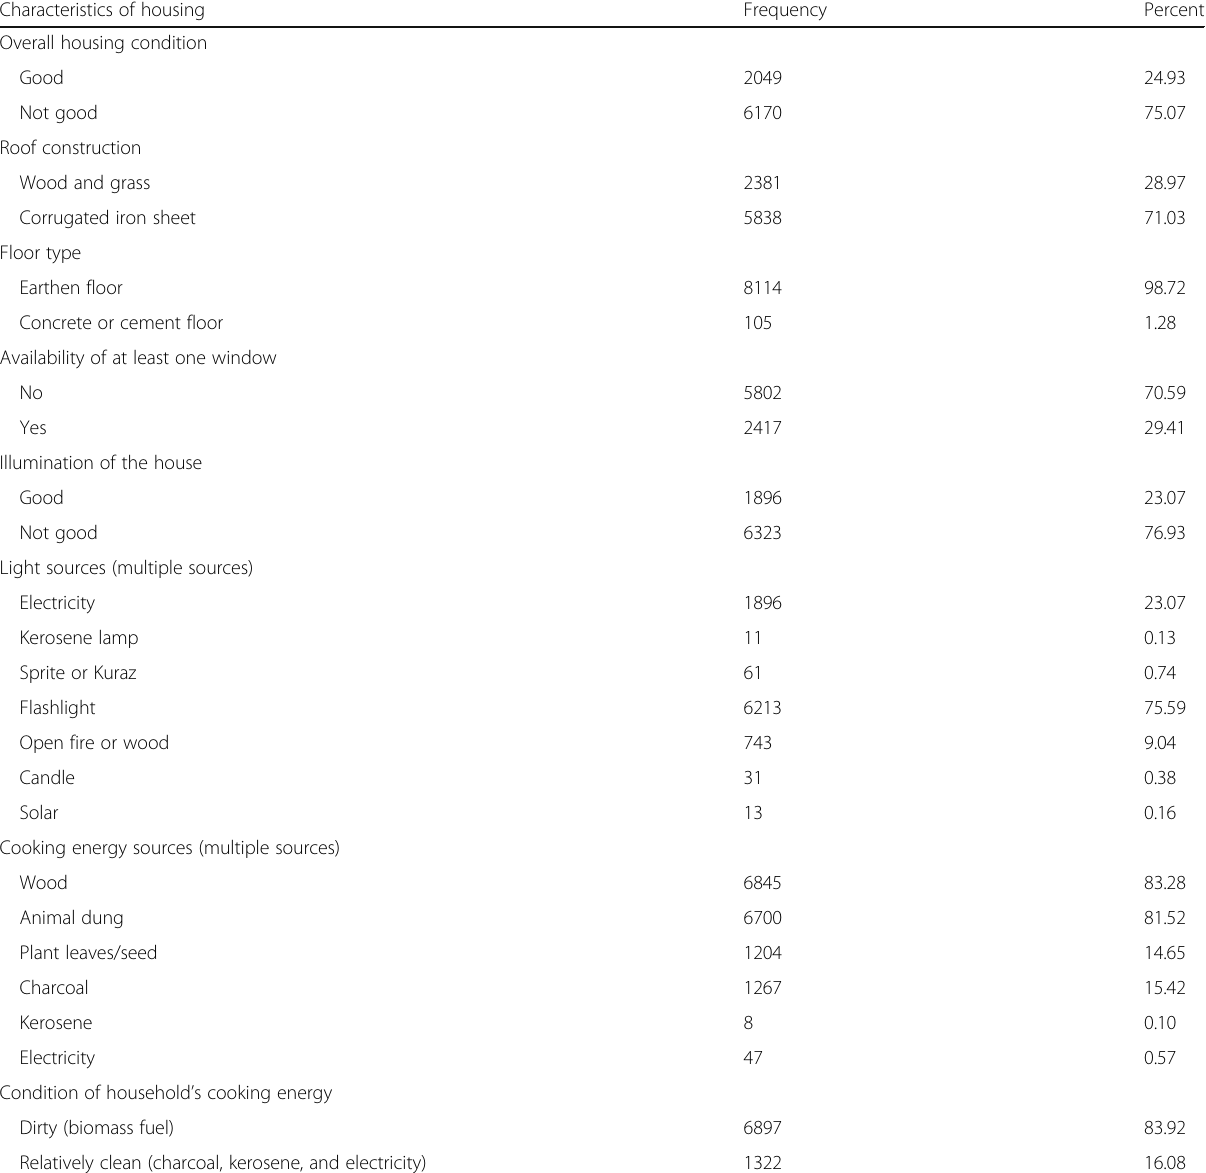
Table 2 Housing condition of study participants in DHDSS sites, Dabat, northwest Ethiopia, October to December 2014 Characteristics of